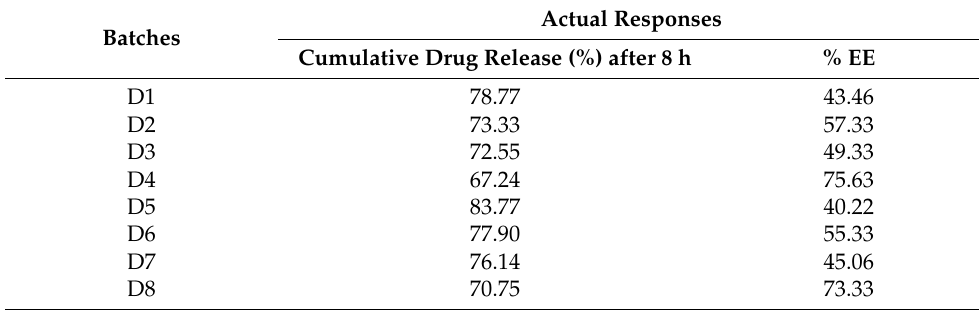
Table 3. Responses of dependent variables for designed batches.